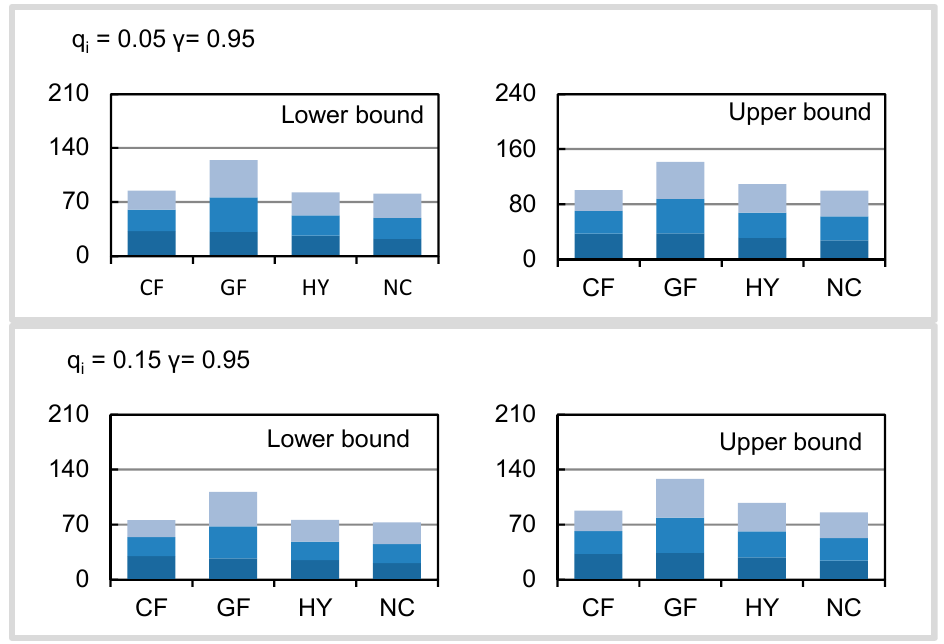
q and γ levels. ( Note: i